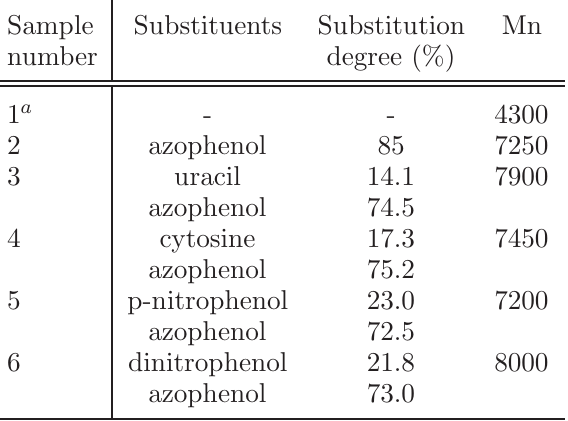
Table 1 Some characteristics of the synthesized polymers.